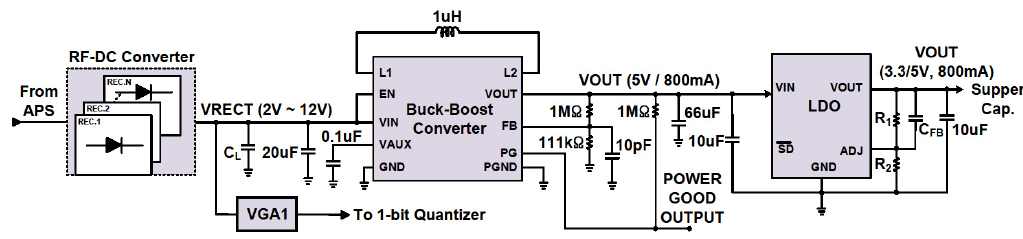
Figure 4. Block diagram of the proposed energy harvesting (EH) path.